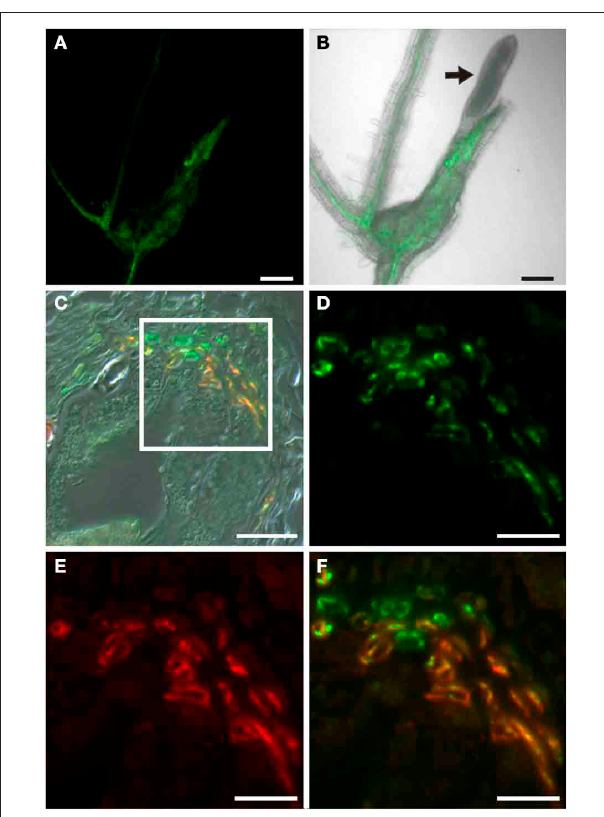
FIGURE 9 | Auxin response in roots of H. schachtii -infected P DR5 :ER - GFP Arabidopsis plants 14dai. (A,B) GFP fluorescence in intact syncytia. (A) GFP fluorescence, (B) Overlay of GFP fluorescence and bright field image, arrow points to the nematode. (C) Bright field image of a section through a syncytium 14 dai. (D–F) is a detail of the indicated position in (C) . ( D) Auxin responsive cells decorated by a GFP antibody. Green color results from a Cy2-conjugated secondary antibody. (E) Cells decorated with the sieve element marker antiserum RS6. Red color results from a Cy3-conjugated secondary antibody. (F) is an overlay of (D,E) . Scale bars represent 100 µ m in (A,B) , 20 µ m in (C) and 10 µ m in (D – F) .